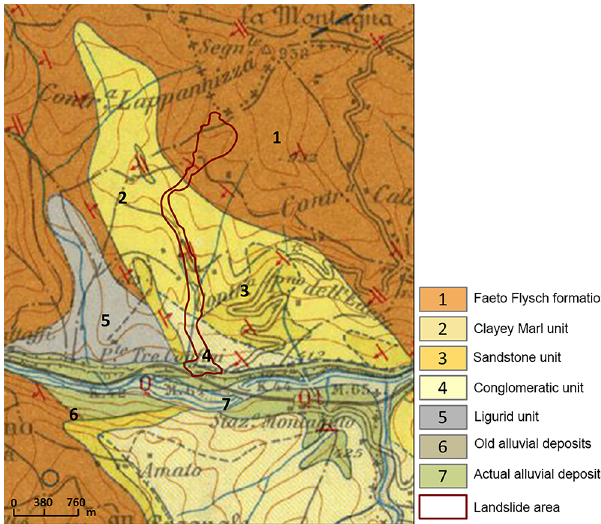
Figure 2. Geological setting: location of the landslide area (red line) and geological map of the study area (1 : 100000, Italian Geological Map No. 174 – Ariano Irpino), according to D’Argenio et al. (1975); the 2, 3, and 4 units have been described as the Villamaina